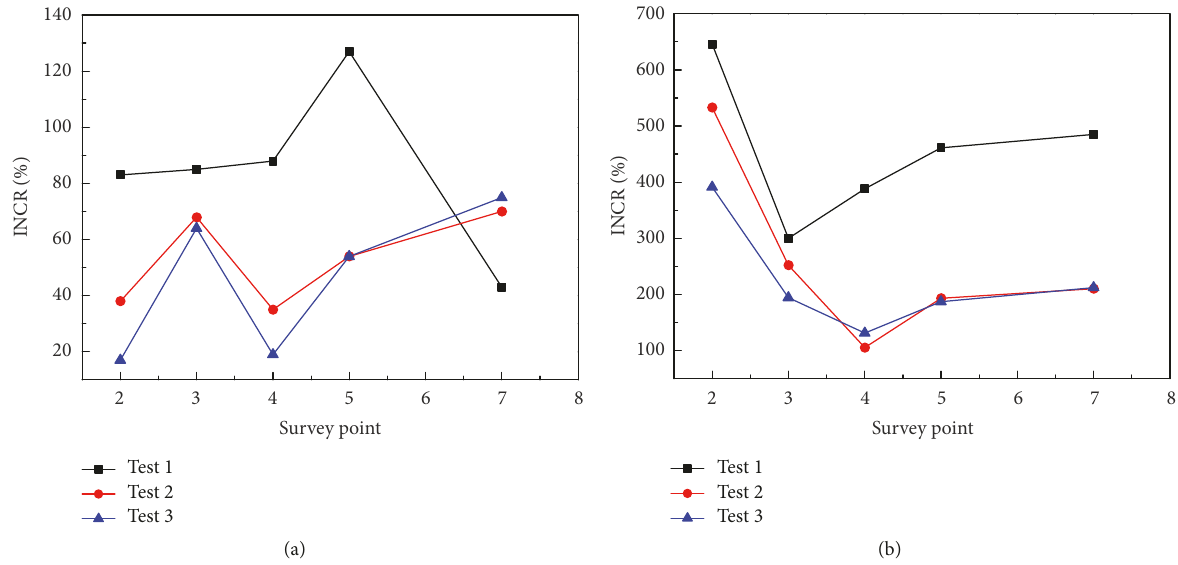
Figure 10: Comparison of INCR in tests under (a) excitation MW-2 and (b) excitation MW-3 as compared to excitation MW-1.